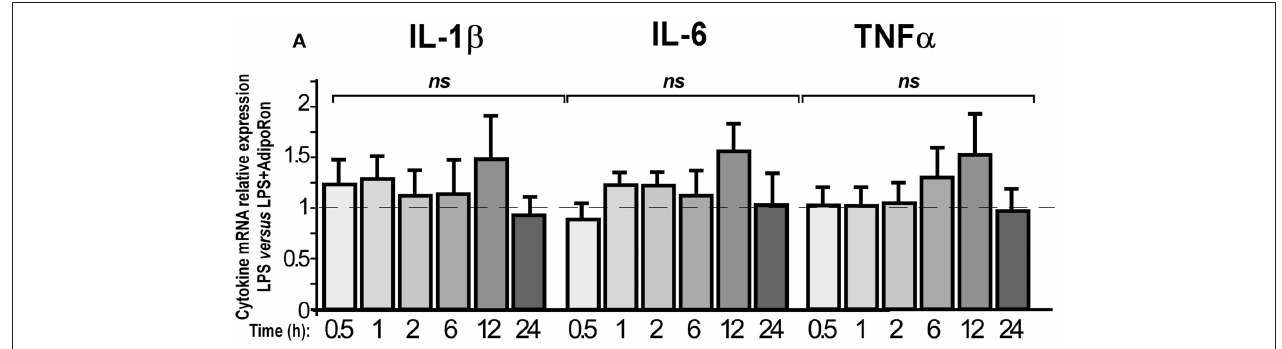
FIGURE 10 | AdipoRon, a small AdipoR agonist, doesn’t exert anti-inflammatory effects on BV2 cells. BV2 cells were pre-treated with vehicle or AdipoRon (10 − 6 M) before treatment with LPS (0.5 µ g/ml) for the indicated period of time. Levels of IL-1 β , IL-6, TNF α mRNAs were quantified by qRT-PCR. N variance (ANOVA) was carried out, ns,